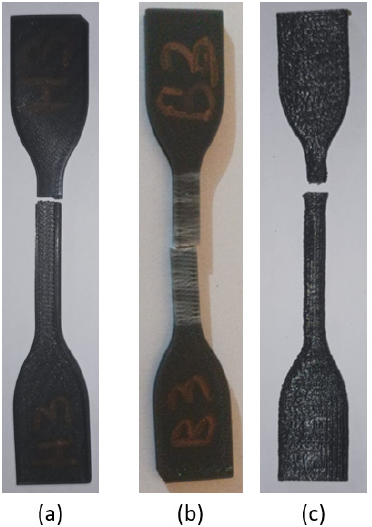
Figure 18. Tensile tested specimen: ( a ) PLA and ( b ) ABS both with 2% graphite and infill of 80% printed using the PRUSA I3 MK3S printer without laser heating, and ( c ) PLA + 2% graphite printed using the Wanhoa Duplicator equipped with the laser diode.